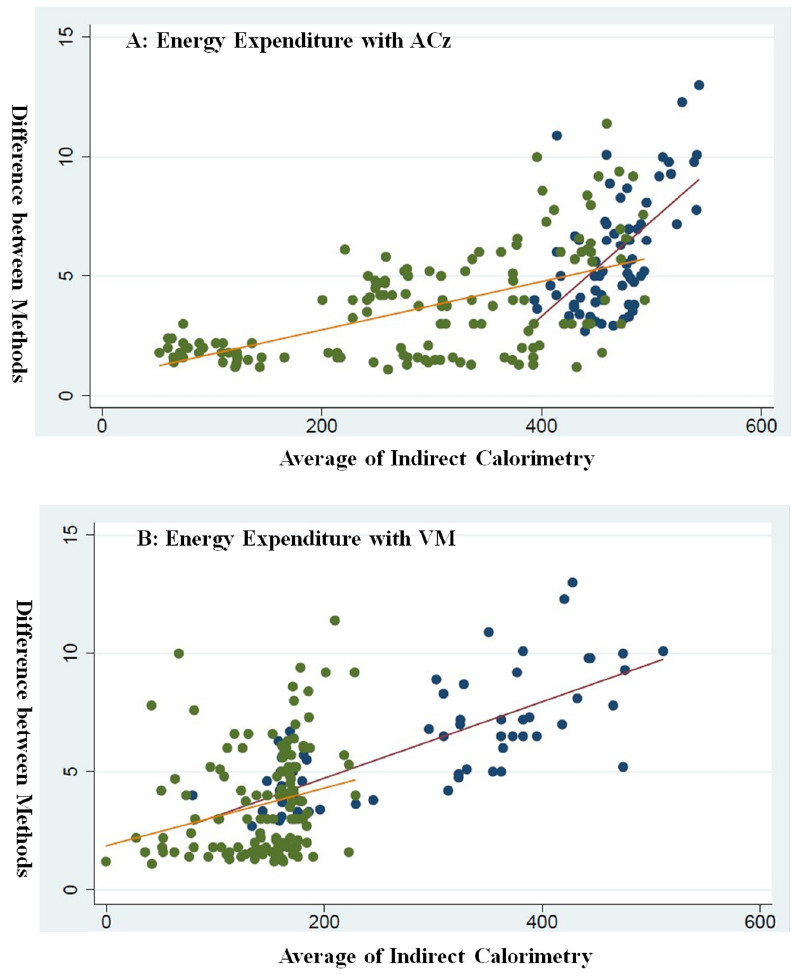
Figure 2. ( A ) Sca tt er plot showing the energy expenditure assessed by energy consumption algo- rithm (based on the ACz) for control subjects across seven activities (n = 20; 10 males and 10 females). ( B ) Plot showing the energy expenditure assessed by energy consumption algorithm (based on the VM) for control subjects across seven activities (n= 20; 10 males and 10 females). Blue spot indicates walking and running group with red solid line as mean value, and green spot indicates the non-walking and running group with orange solid line as mean value.